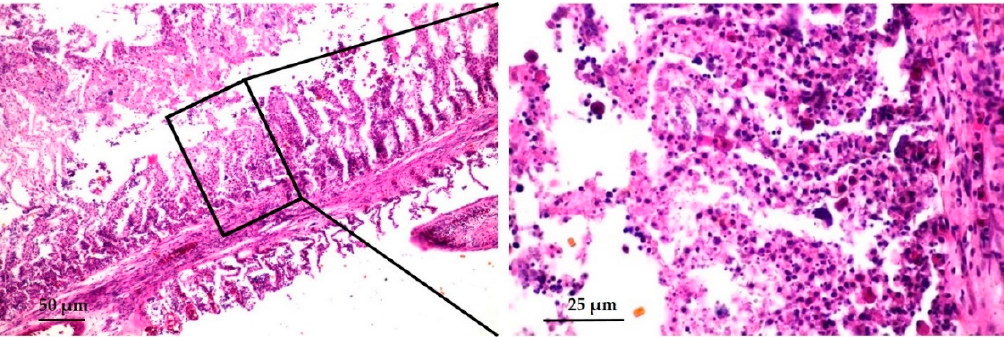
Figure 3. Histopathological studies of gills from CEV-affected koi. The gill filament showing severe necrosis of epithelial cells and infiltrating of eosinophilic granular cells. (hematoxylin and eosin staining, scale bar = 50 and 25 μ m, respectively) .